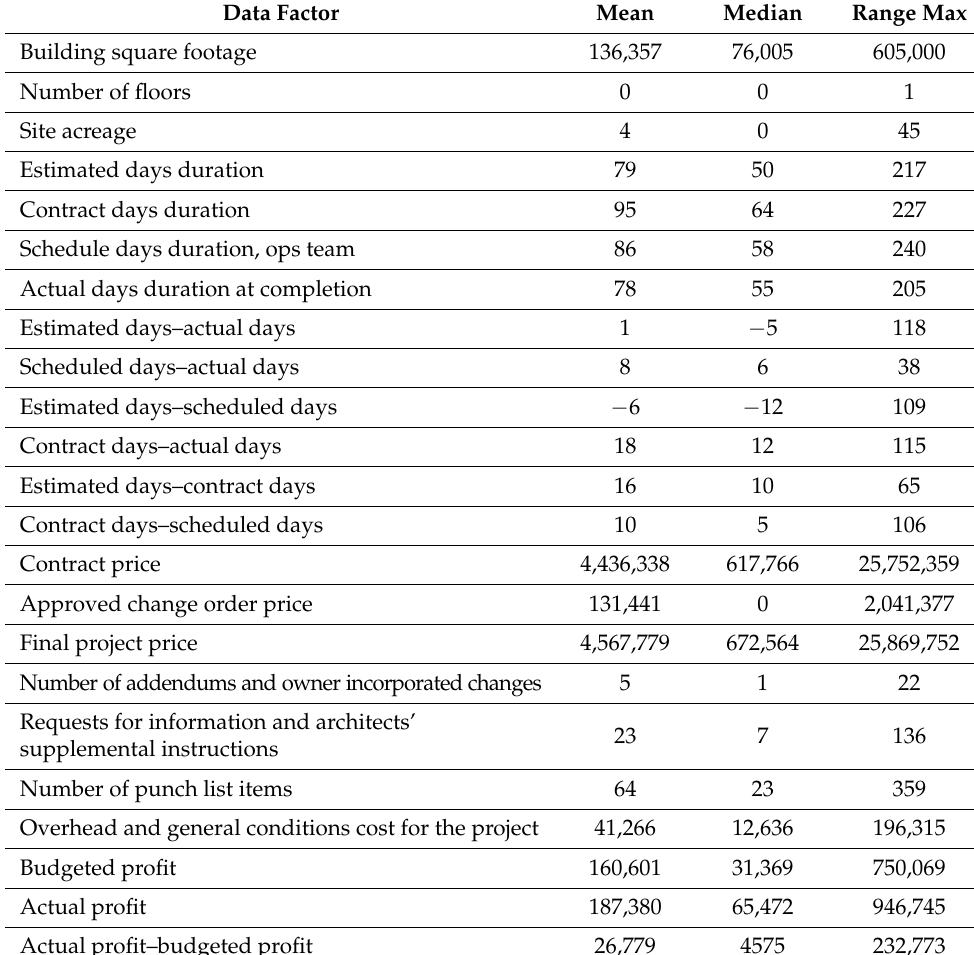
Table 3. Data factor statistical analysis for project